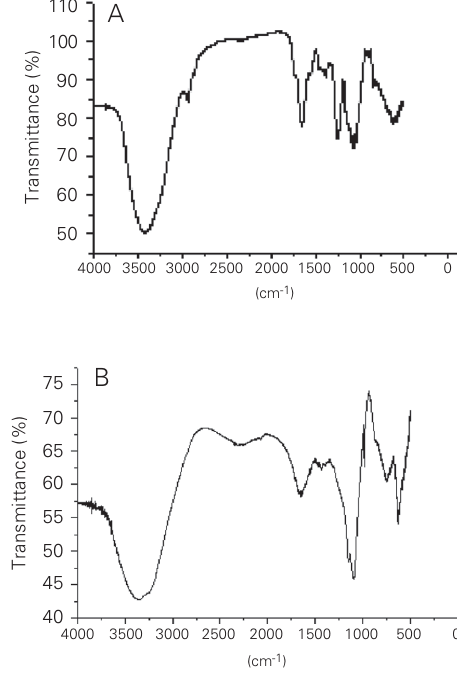
Figure 5. 13 C-NMR spectrum at 500 MHz of sulfated fucans from the brown alga Padina gymnospora . The spectrum was recorded at 60 º C in a D 2 O solu- tion of fraction PF1.